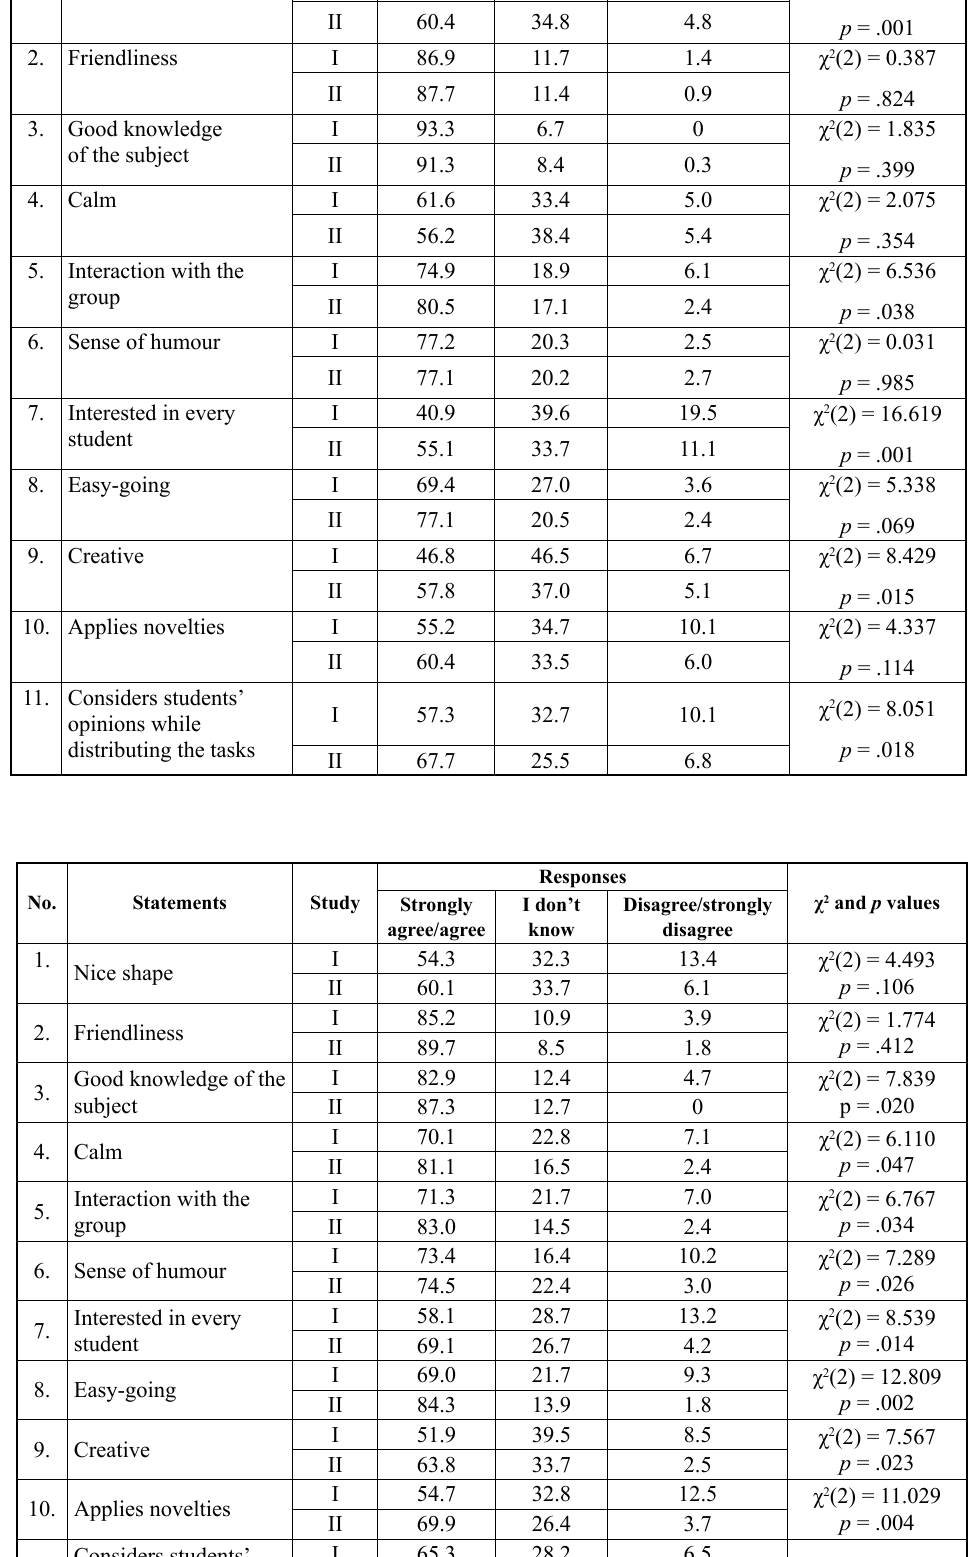
Table 2. Female stu- dents’ responses to